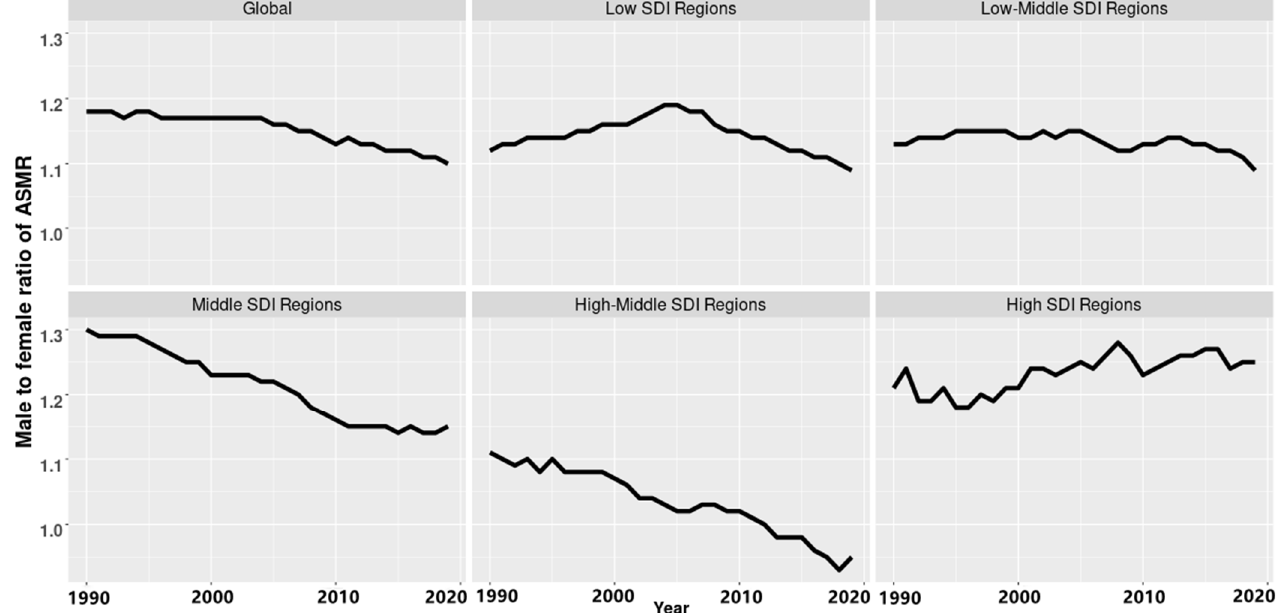
Figure 4. The ratio of males to females in age-standardized mortality rates (ASMR) for PM2.5-related neonatal infections in different socio-demographic index (SDI) regions in